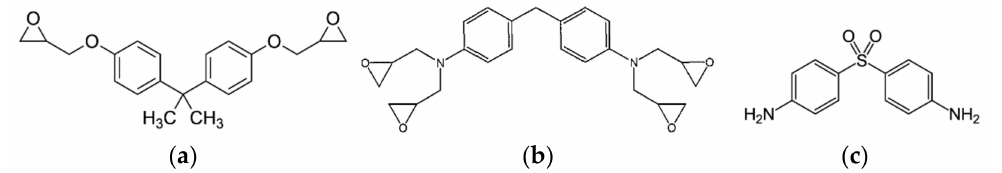
Figure 1. ( a ) DGEBA resin, ( b ) TGMDA resin, and ( c ) 4,4 (cid:48) -DDS hardener.